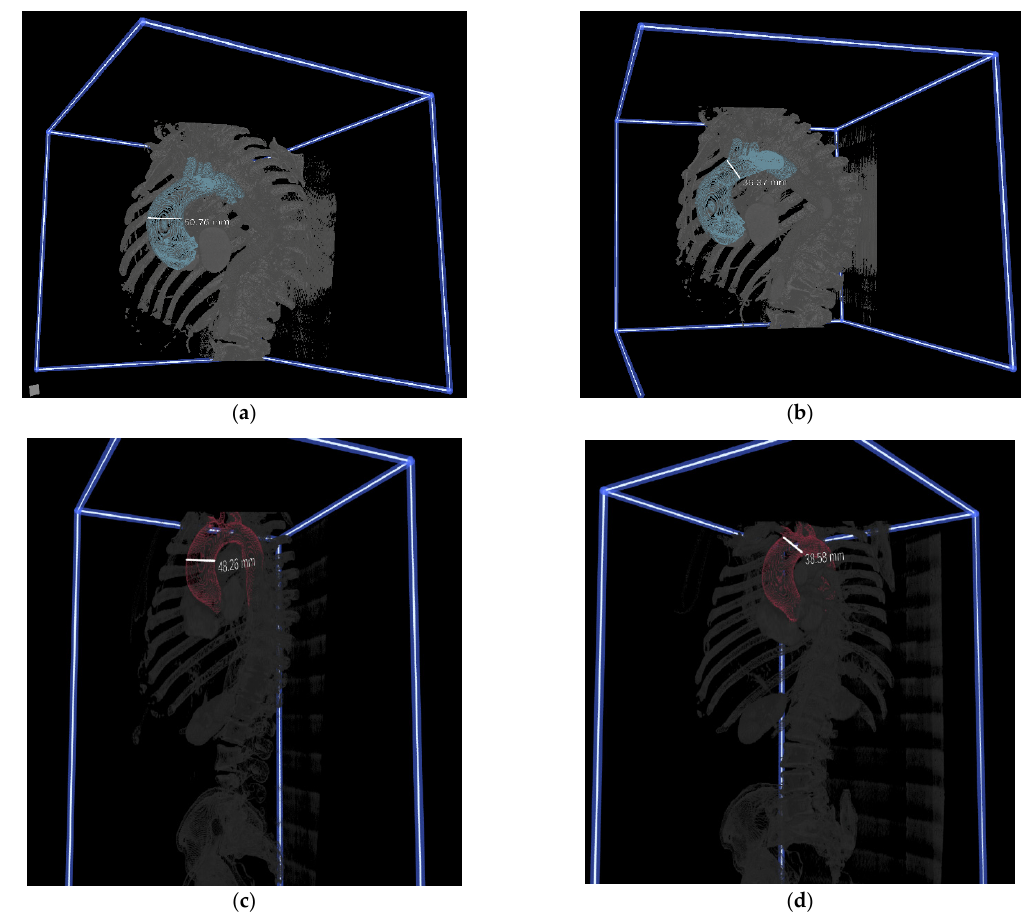
Figure 1. Screen captures of 3-dimensional (3D) virtual reality (VR) rendered images. Evaluations and measurements of 3D reconstructions of ascending aortas and arches in 3D VR for preoperative planning. ( a , c ) Measurements of maximal ascending aortic diameter. ( b , d ) Measurements of aortic diameter proximal to the brachiocephalic artery.